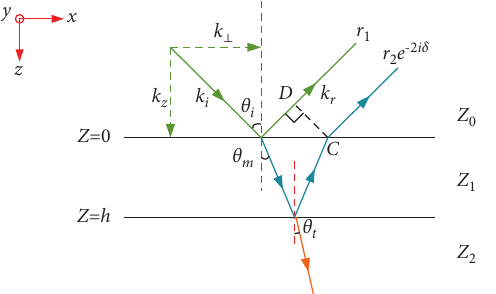
Figure 2: Acoustic wave propagation in anti-reflection